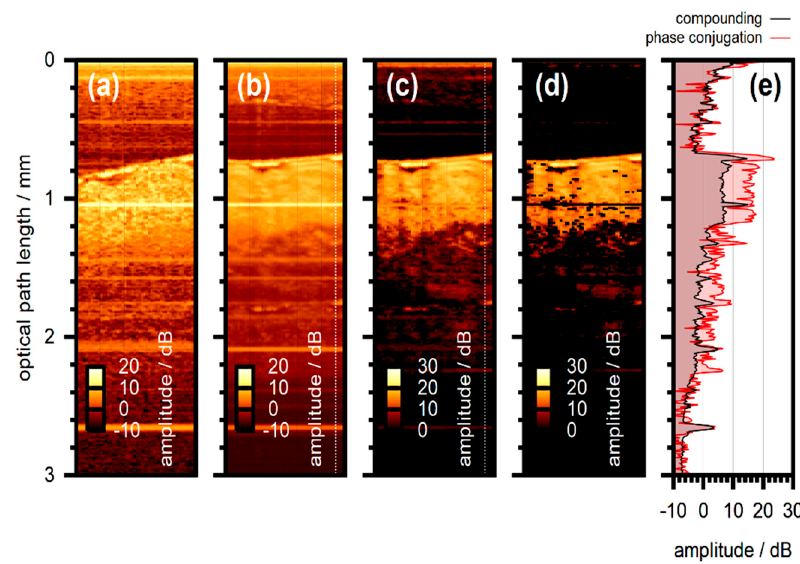
Figure 13. Wavefront shaping at layered scattering phantom. Phase conjugation with biological tissue. ( a ) Conventional OCT scan. ( b ) Image captured with a speckle-compounding algorithm to reduce speckle contrast. ( c ) Scan acquired with phase conjugation. Number of modes N = 256. ( d ) Phase conjugation with additional artefact suppression. ( e ) Amplitude of the two A-scans marked by the dashed line in panels ( b ) and ( c ), respectively. The amplitude color-scale corresponds to the same dynamic range of 30 dB for all scans. Adapted from [8,106], with permission.